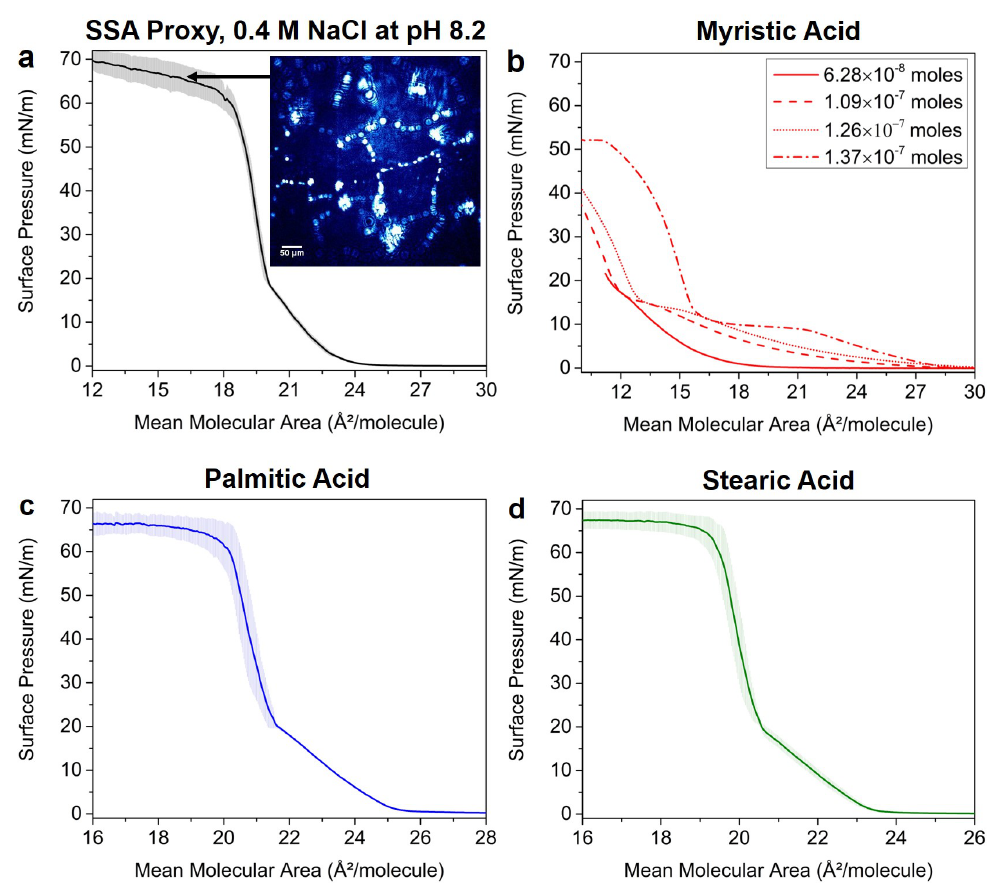
Figure 1. Π − A isotherms of the sea spray aerosol (SSA) proxy film and its individual components at pH 8.2: ( a ) SSA proxy film and a Brewster angle microscope (BAM) image of the monolayer collapse; ( b ) myristic acid (MA) spread at different amounts at the air–water interface; ( c ) palmitic acid (PA); and ( d ) stearic acid (SA). The BAM image scale bar is 50 µ m (see Supplementary